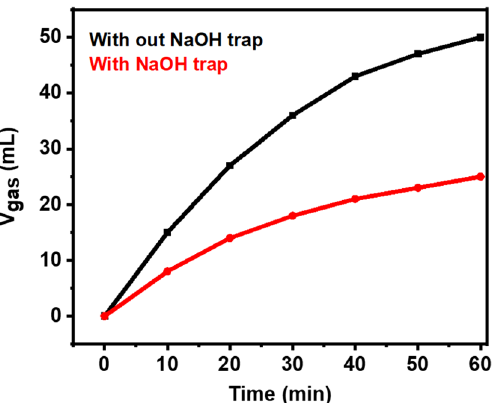
Figure 11. The comparison of the volume of gas produced by using Ag 1 Pd 1 /SLCN for dehydrogenation of aqueous FA solution with and without NaOH trap under visible light irradiation.